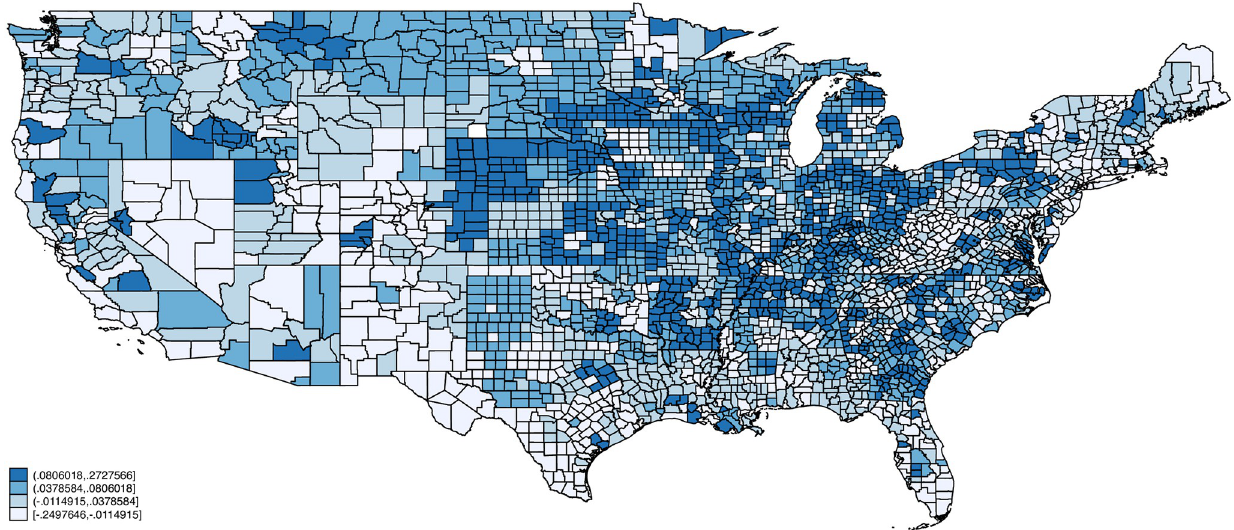
Fig 4. Essential workers by county. Notes: Each county is assigned the average value of the critical index based on the distribution of employment across occupations using 2018 American Community Survey (ACS) data. Endpoints correspond to quartiles. Person weights from the ACS are used.